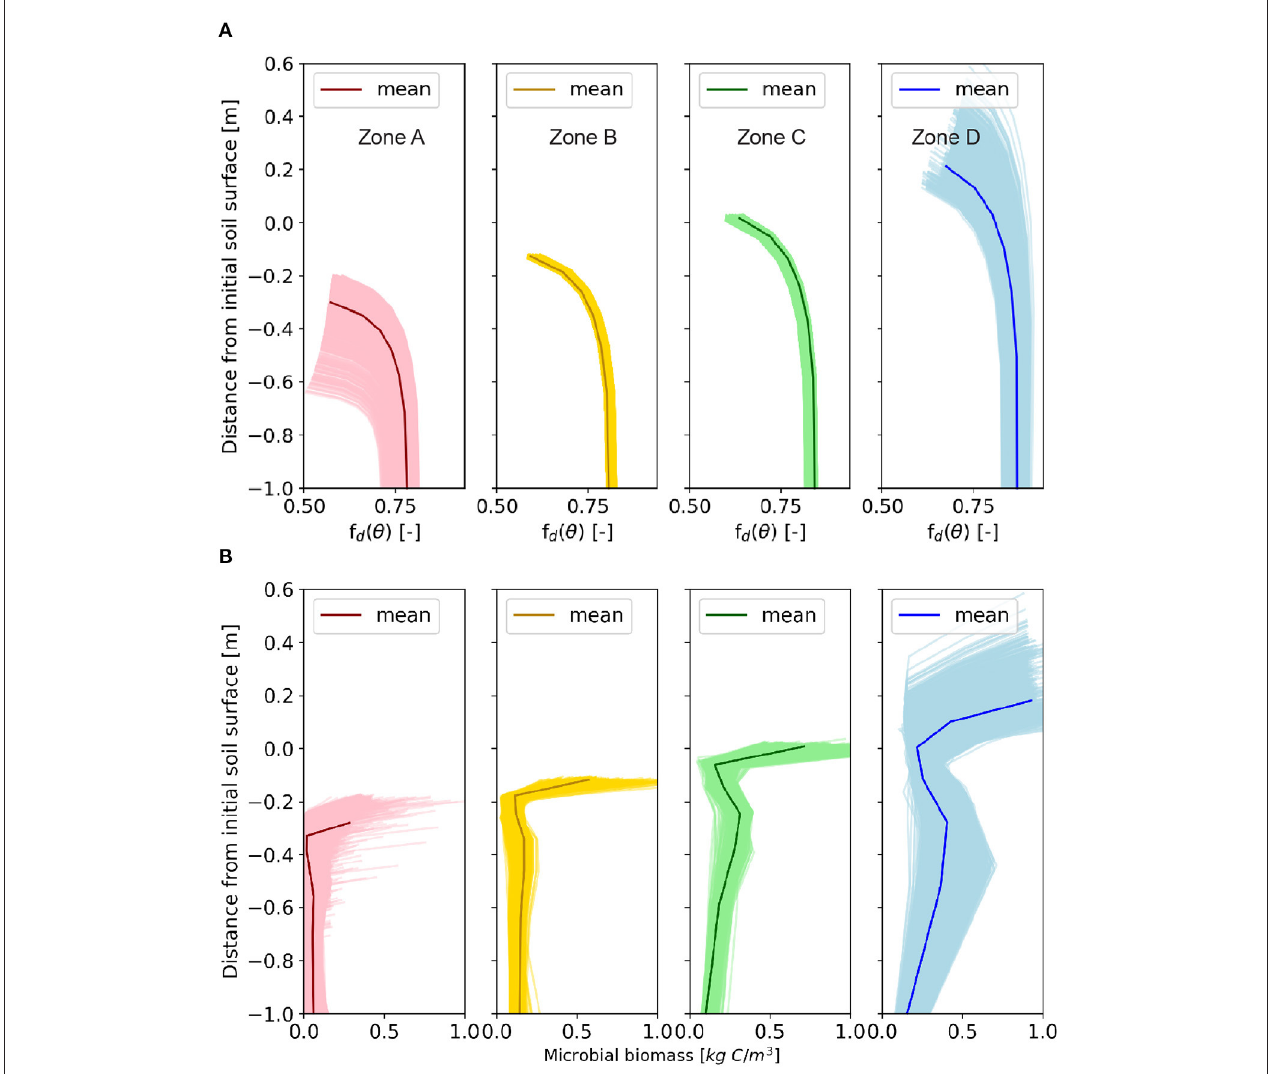
FIGURE 6 | The vertical profiles of (A) soil moisture index, f d ( θ ), and (B) microbial biomass at year 85. The vertical profiles of f d ( θ ) and microbial biomass of the four zones, from Zone A to D corresponding to the highest erosional zone, moderate erosional zone, moderate depositional zone, and the highest depositional zone, which correspond to the areas in Figure 2a